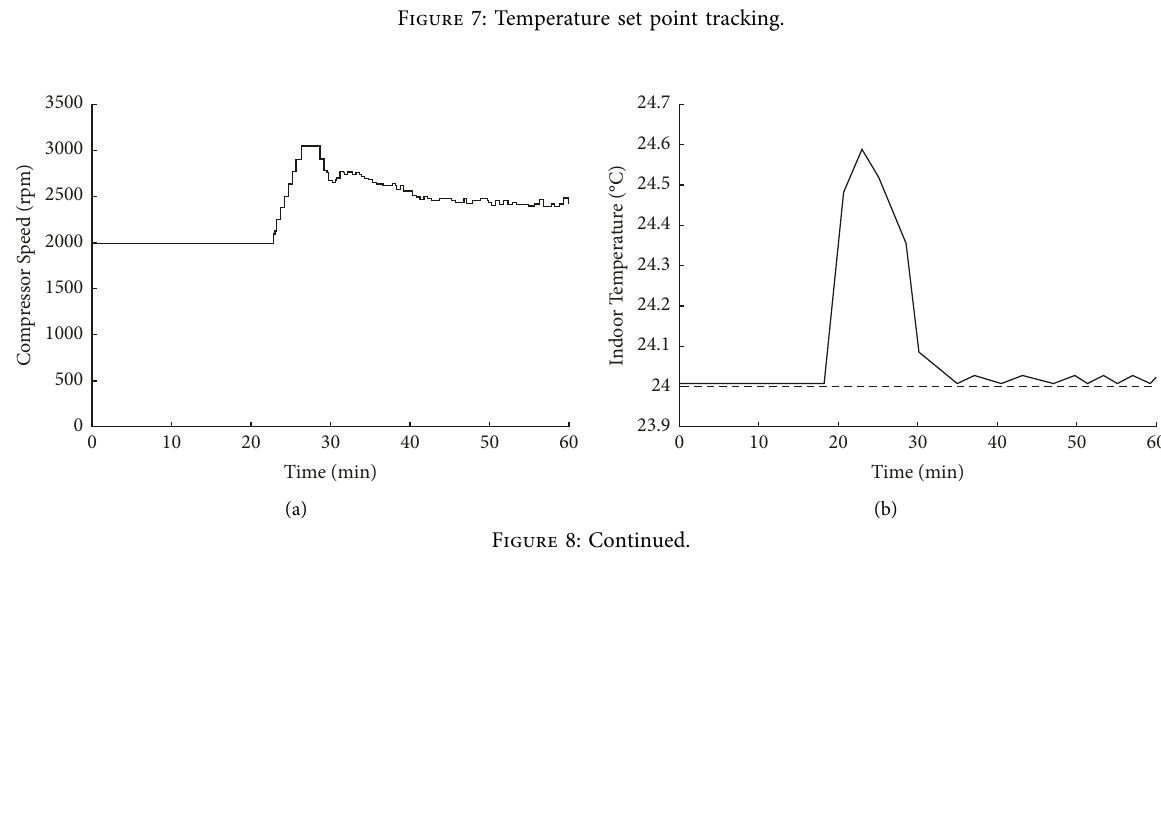
Figure 7: Temperature set point